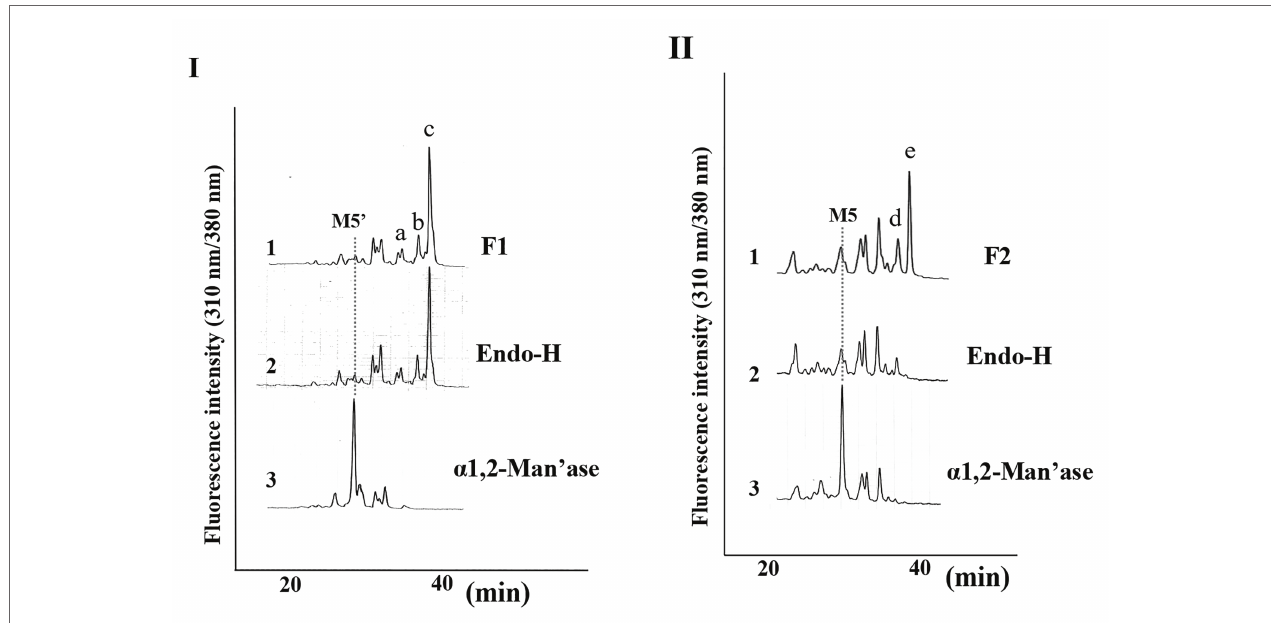
FIGURE 3 | Structural analysis of free N -glycans (FNGs) in pumpkin microsomes. (I) SF-HPLC of glycosidase-digested F1. 1, F1 obtained in Figure 1 . 2, End-H- digested F1. 3,